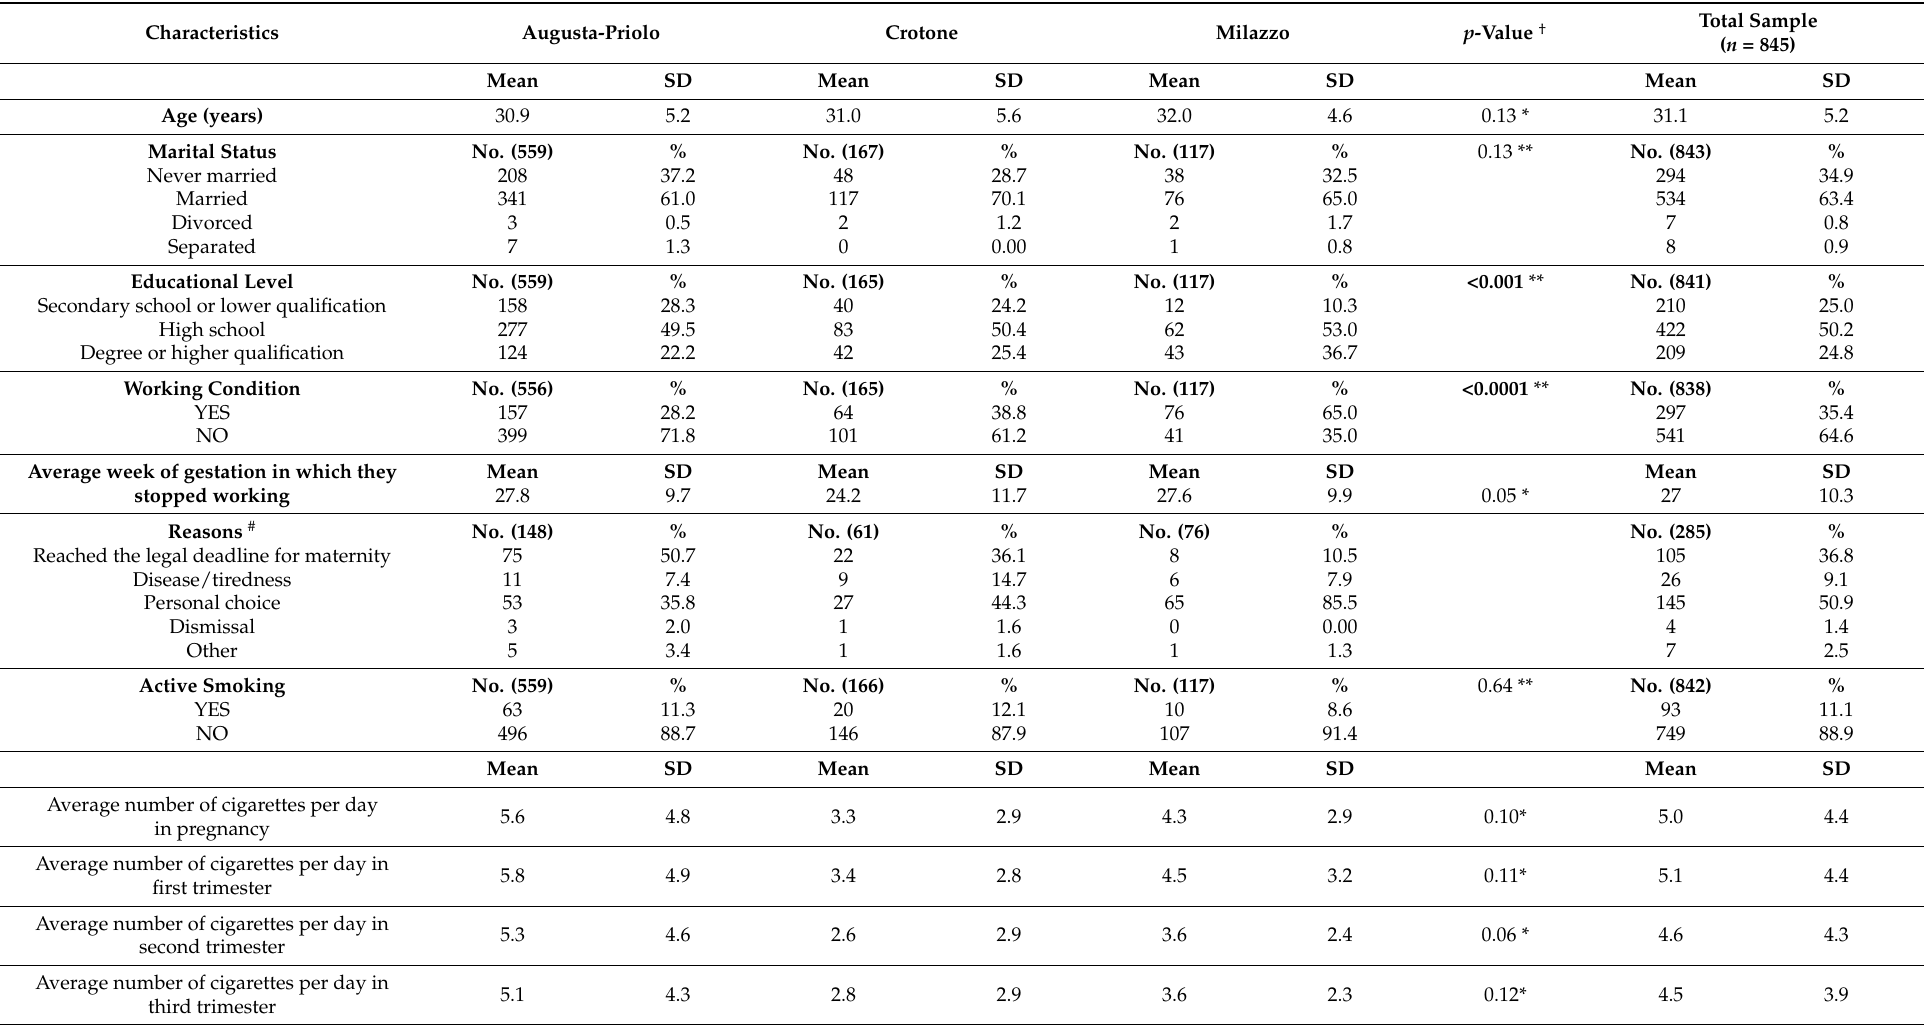
Table 1. Characteristics of the enrolled women in the total sample and in each national priority contaminated site (NPCS): continuous variables are reported as mean ± SD, while categorical variables are reported as numbers and percentages. Significant p -values are in bold. For each categorical variable, in parentheses, the total number of responders is